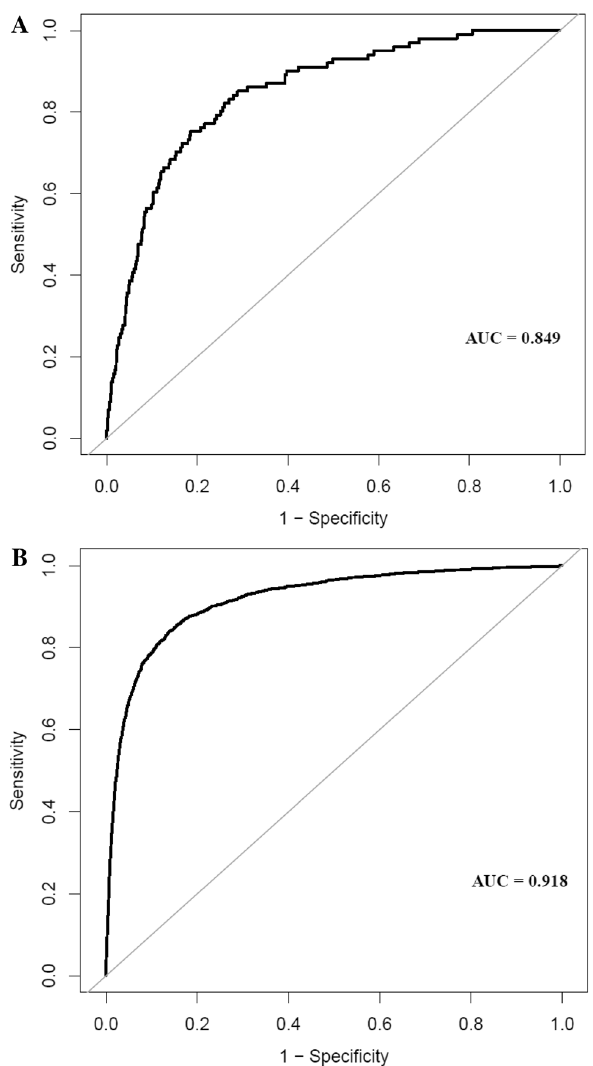
Figure 7. The ROC curves of the nomogram in the external validation cohort ( A ) the overall population of the original study ( B